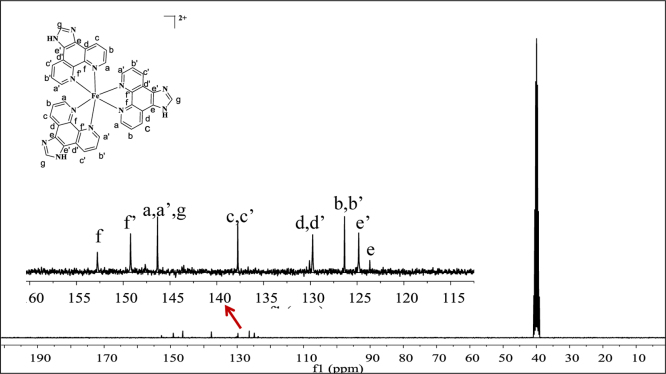
13C NMR spectrum (300 MHz) of complex 3 dimethylsulfoxide-d6.